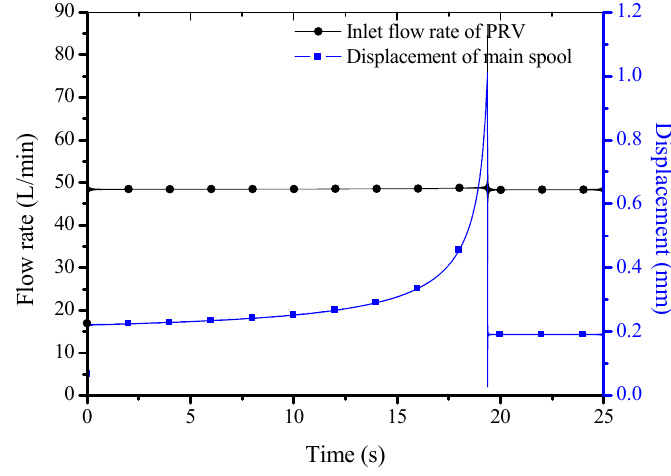
Figure 7. Flow rate and displacement of main valve of the PRV during the energy regeneration process.